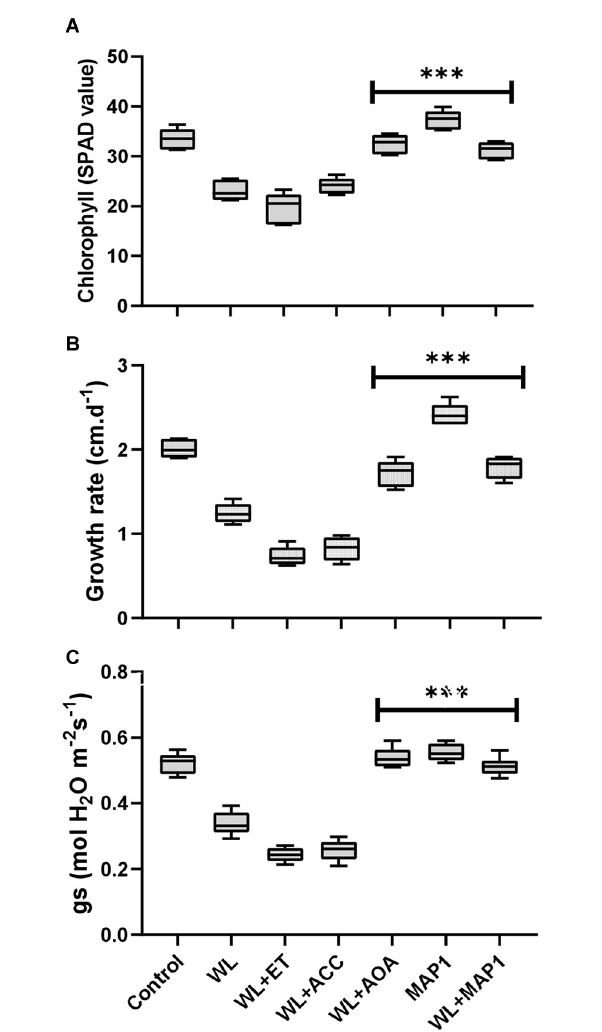
FIGURE 4 | Determination of the effect of WS on (A) chlorophyll content, (B) growth rate, and (C) stomatal conductance of wheat plants with and without MAP1 inoculation. Quantitative data represent means ± SD of three independent experiments and at least six technical replicates each. The asterisks indicate a significant difference compared to untreated control ( ∗∗∗ p ≤ 0.002).